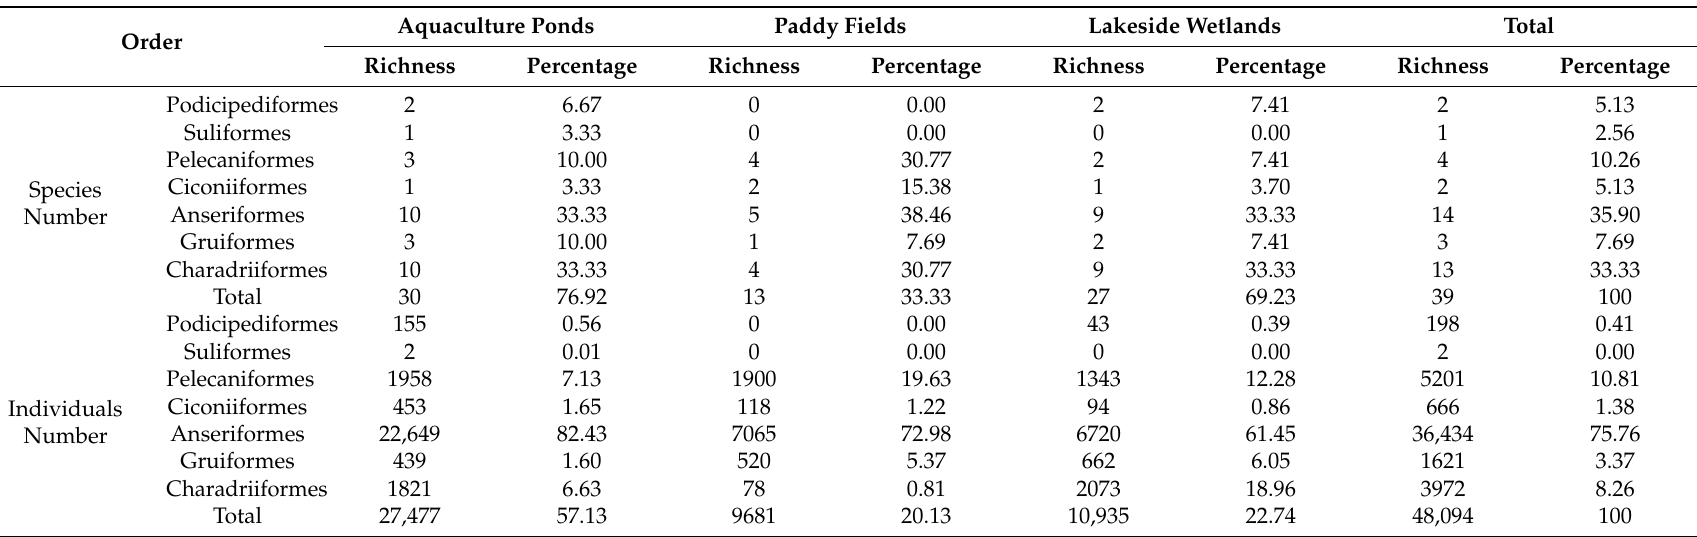
Table 2. Species and individuals of waterbirds in di ff erent habitat